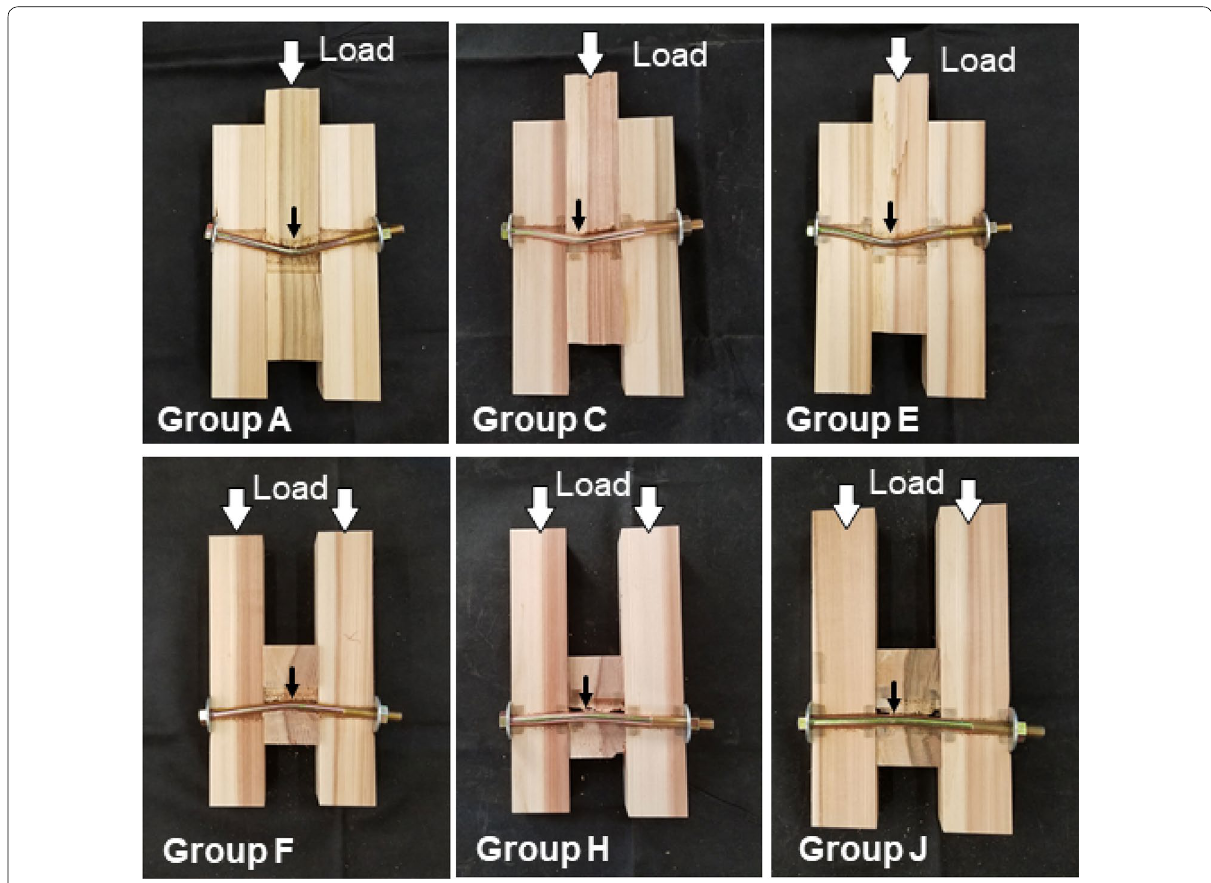
Fig. 6 Examples of bending deformation of bolts occurred in the joint specimens